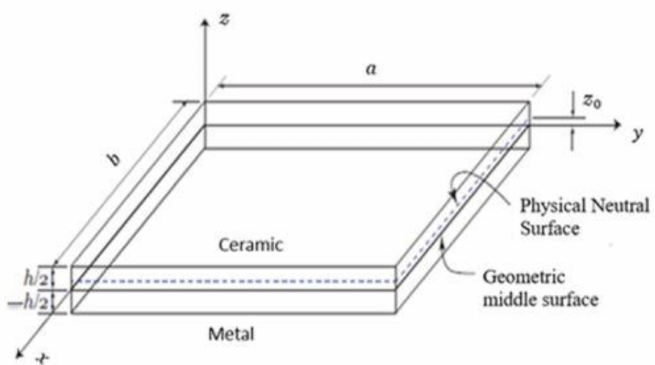
Figure 1. P-FGM plate with physical neutral surface.